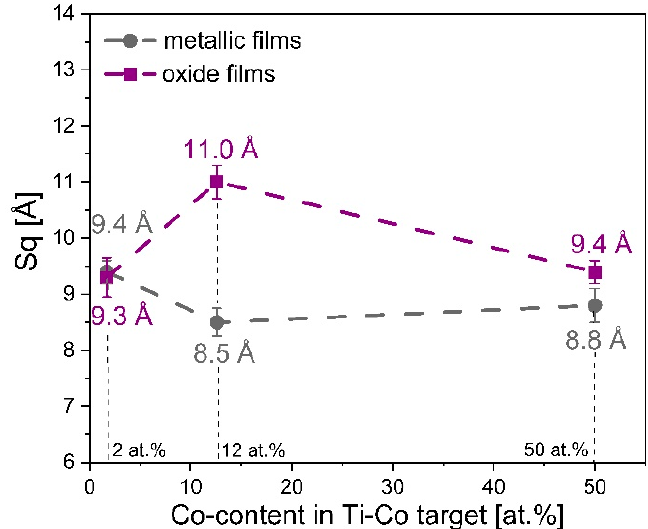
Figure 5. The influence of the Co-content in the Ti–Co target on the roughness of metallic and oxide thin films. Designation: Sq—root mean square roughness.